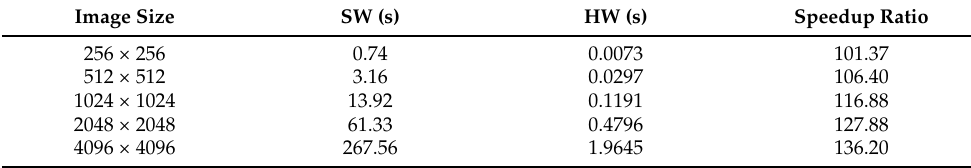
Table 2. CSA execution time.